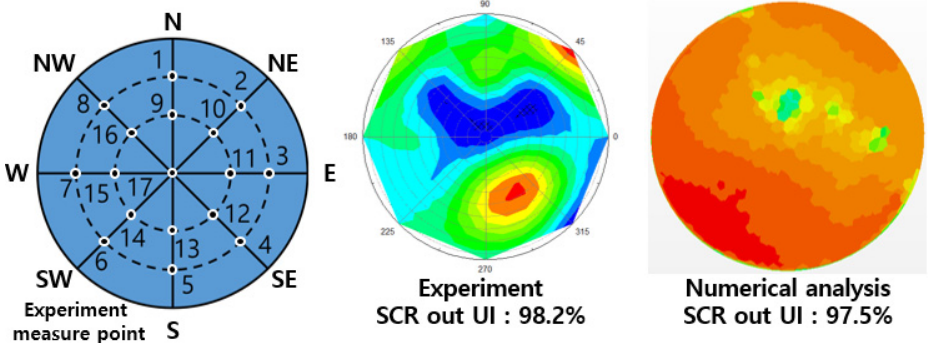
Figure 6. Uniformity index (UI) comparison: experimental result vs. numerical analysis result. sis